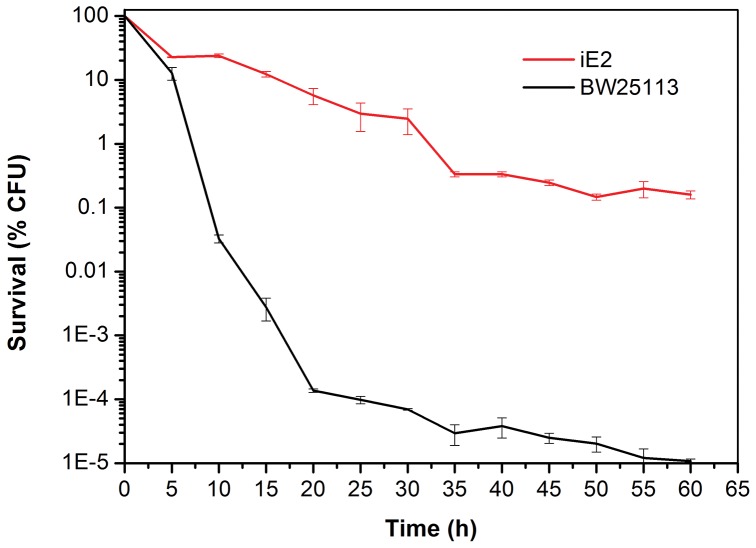
Survival comparison between iE2 and parent strain BW25113 when exposed to 150 g/L ethanol.Cells were grown to mid-exponential phase (OD600 ∼0.6) in LB medium before being exposed to 150 g/L ethanol for a period of 1 h.